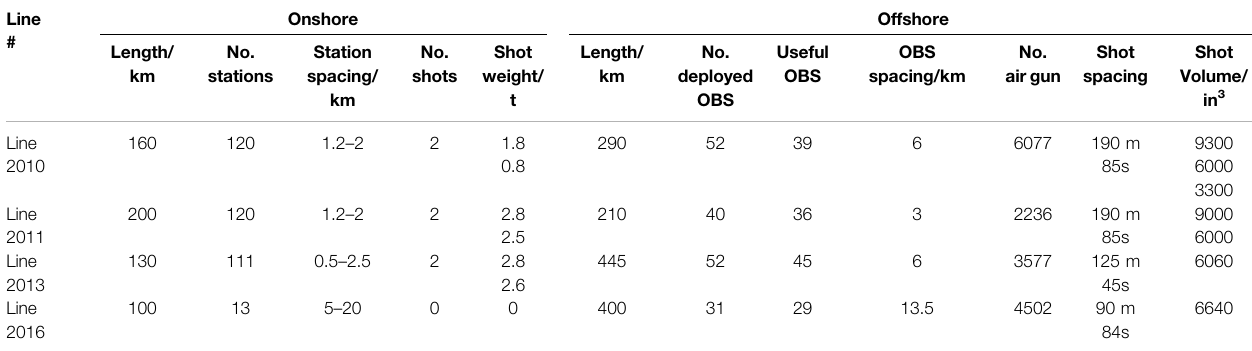
TABLE 1 | Observation parameters of the wide-angle seismic survey pro fi les